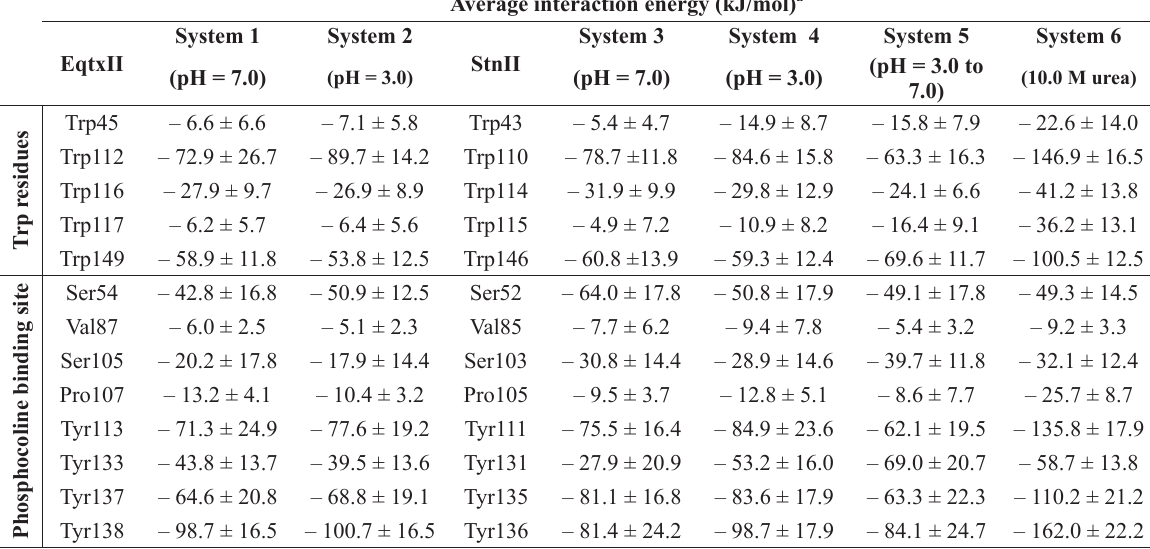
Interaction energy analysis between Trp